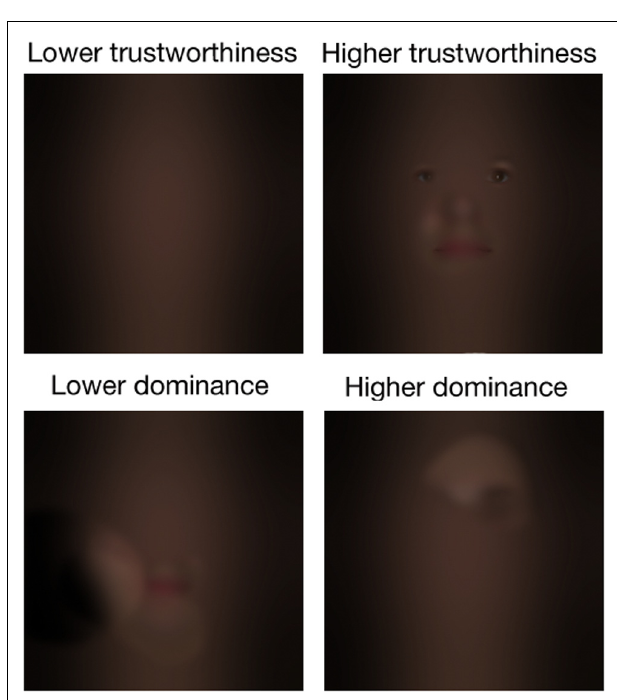
FIGURE 3 | Classification images that reveal potent information used by participants for each social judgment. Note that no visual information is significantly correlated with untrustworthiness (only the lowest un-sampled spatial frequency band is represented).